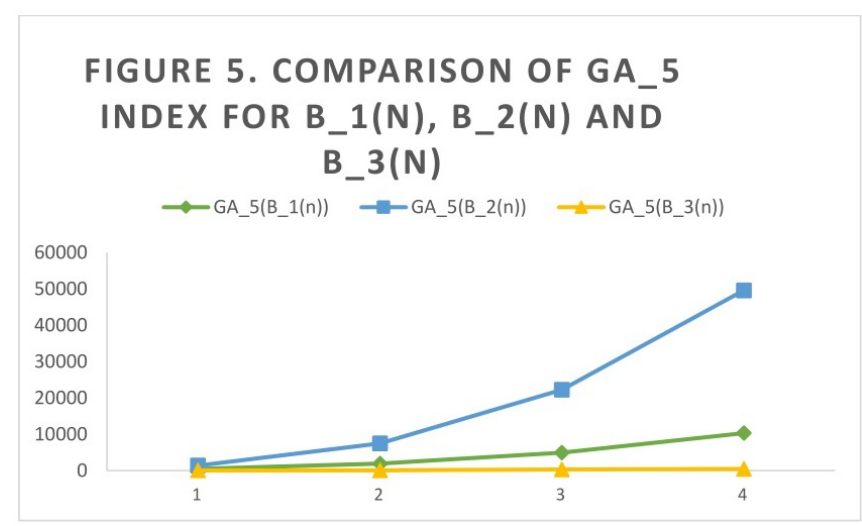
Figure 5. Comparison of GA 5 index for B 1 ( n ) , B 2 ( n ) , and B 3 ( n )